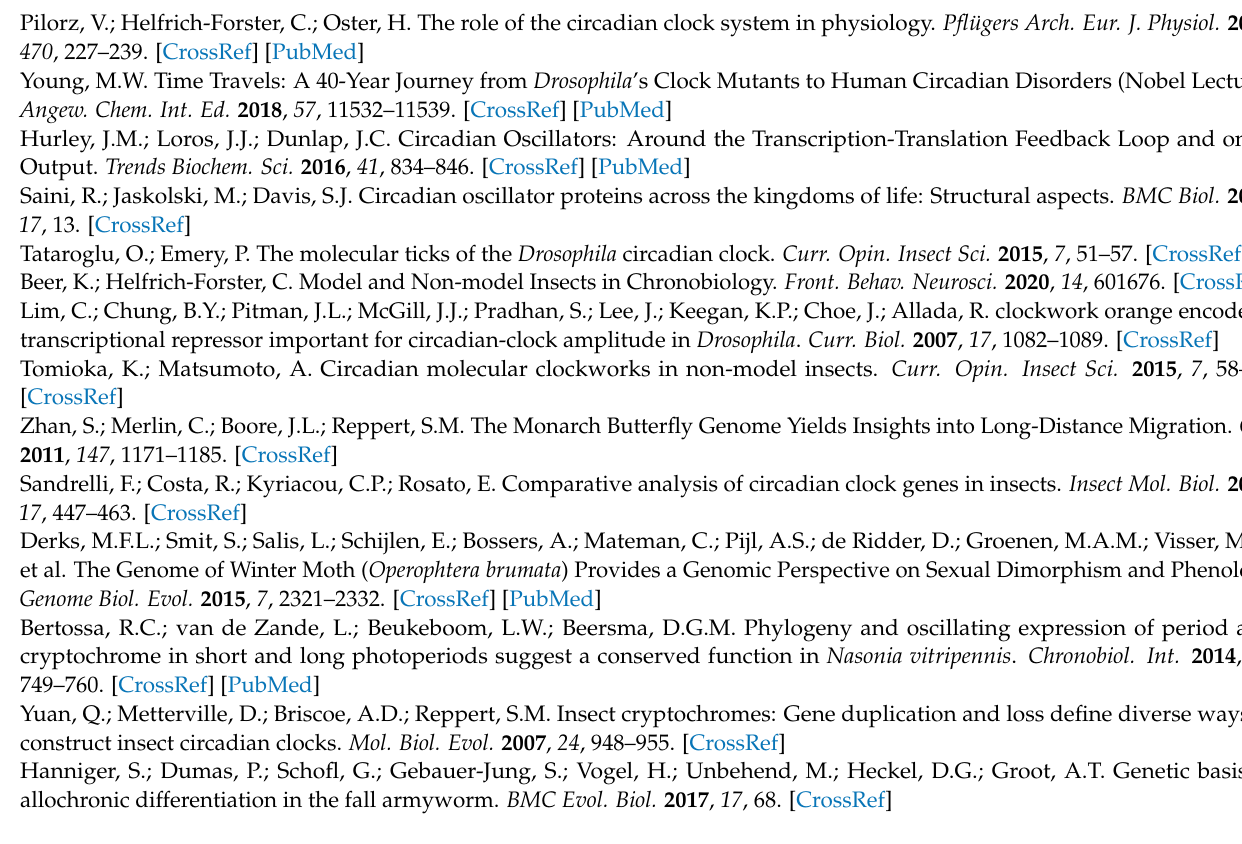
Table S1: PCR primers used in the studies, Table S2: Daily rhythm analysis of changes in the sus- ceptibility to the insecticides for larvae kept under LD and LL using the cosinor method [98,99], Tables S3A–S5A: Daily rhythm of clock genes expression in the fat body, midgut, and Malpighian tubules, respectively, calculated using the cosinor method, Tables S3B–S5B: Daily rhythm of the xenobiotic metabolizing enzymes activity in the larval fat body, midgut, and Malpighian tubules, respectively, calculated using the cosinor method. Table S6: Daily rhythm of changes in the suscepti- bility to the insecticides for larvae with altered activity of the molecular oscillator, calculated using the cosinor